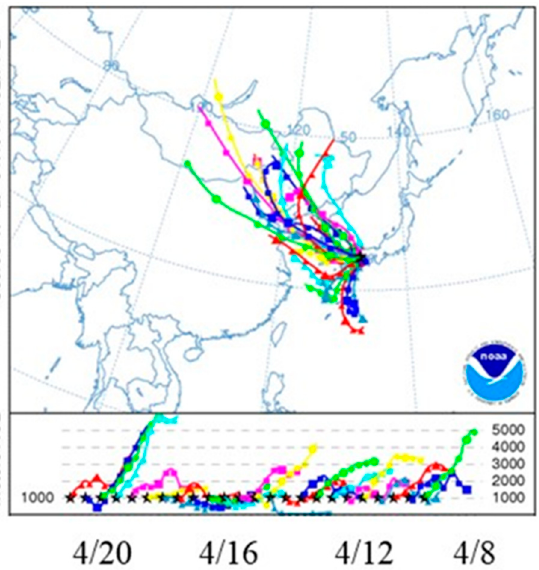
Figure 1. Backward trajectories during the sampling period (8 to 20 April, 2012) in Higashi-Hiroshima. The trajectories started at the height of 1000 m above the sampling site in Higashi-Hiroshima, and run time was 72 h.